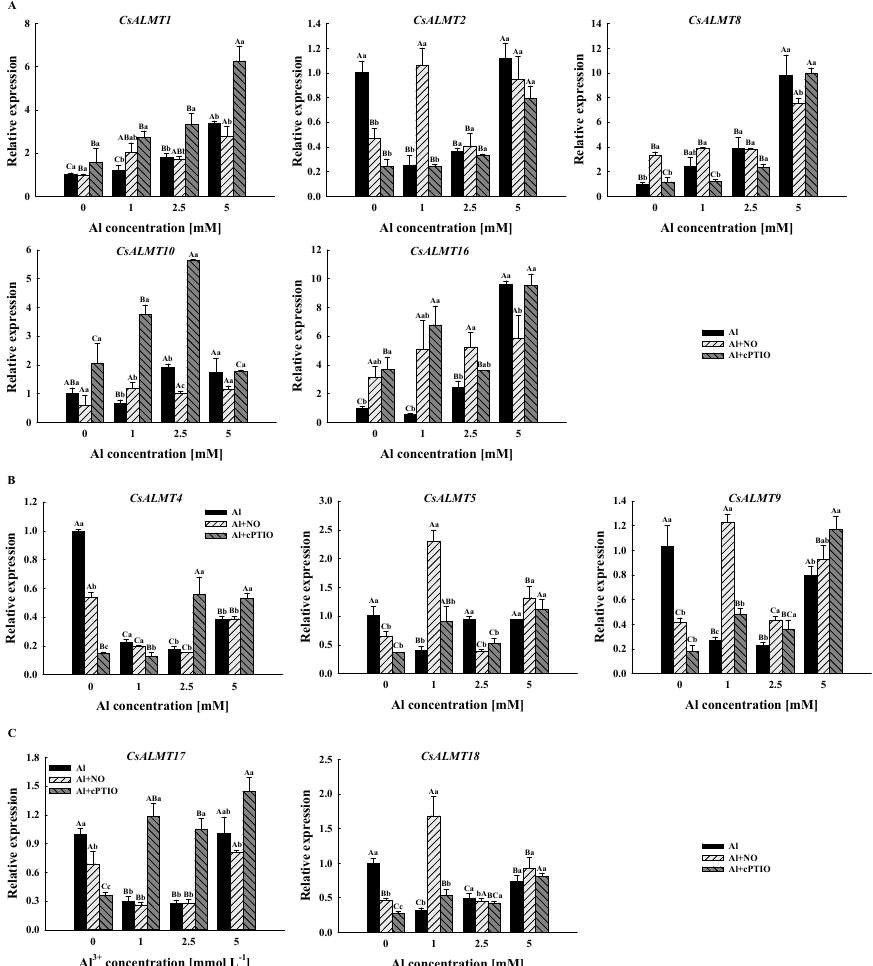
Figure 4. The relative expression levels of CsALMTs belong to subclass I ( A ), subclass II ( B ) and subclass IV ( C ) in Camellia sinensis pollen tubes under different treatments. Al concentration represents the Al 3+ concentration gradient in the culture medium, Al treatment represents the treatment group treated with Al concentration gradient only, Al + NO represents the treatment group treated with Al 3+ concentration gradient treatment and 25 μ M DEA NONOate (nitric oxide donor), Al + cPTIO represents the treatment group treated with Al 3+ concentration gradient treatment and 200 μ M carboxy PTIO potassium salt (nitric oxide scavenger). Different lowercase letters represent significant differences among different nitric oxide conditions under the same Al 3+ concentration treatment, and different uppercase letters represent significant differences among different Al 3+ concentration treatments under the same nitric oxide conditions (n = 3, p < 0.05), as determined by the Duncan test.